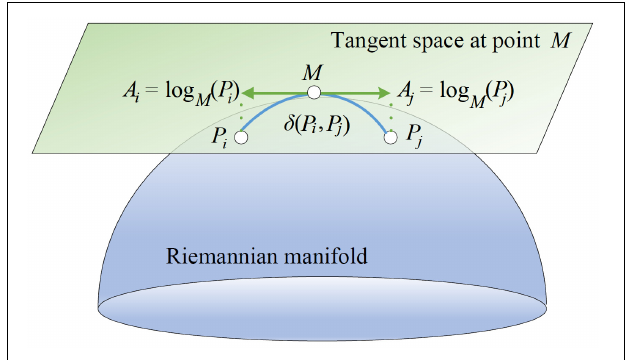
FIGURE 2 | A Riemannian manifold and its tangent space at a point.